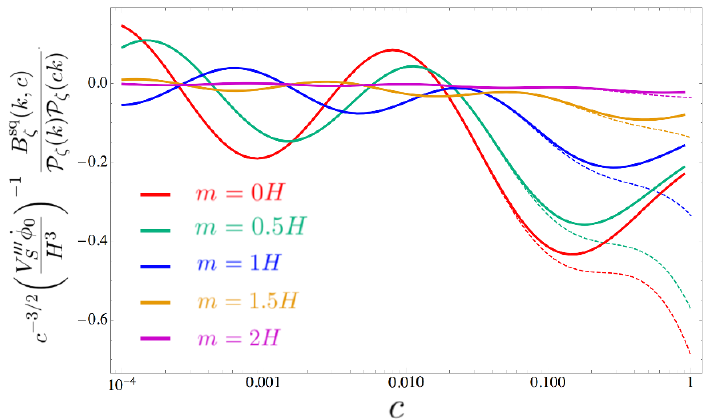
Figure 11 . In the squeezed limit, the three-point function logarithmically oscillates as a function of c. This behavior is illustrated for (cid:22) = 2 H and m = 0, 0 : 5 H , H , 1 : 5 H , and 2 H . The solid lines show the exact behavior as a function of c (i.e. using equation (6.9)) whereas the dotted lines show the approximate behavior to quadratic order in c (i.e. using equation